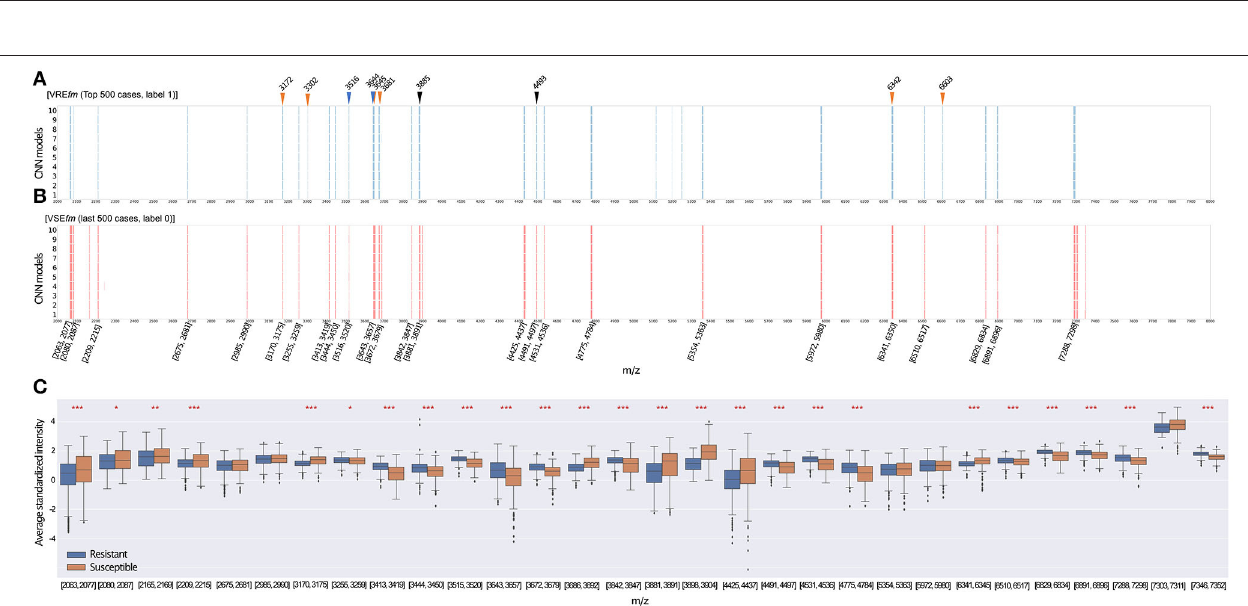
FIGURE 4 | Comparison of prediction performance in terms of accuracy (A) and AUC (B) using different models. Multiple comparison tests on the different units were applied in the models using one-way ANOVA, following the post-hoc Tukey HSD test for paired difference with a p -value < 0.05. Different letters indicate a significant difference.